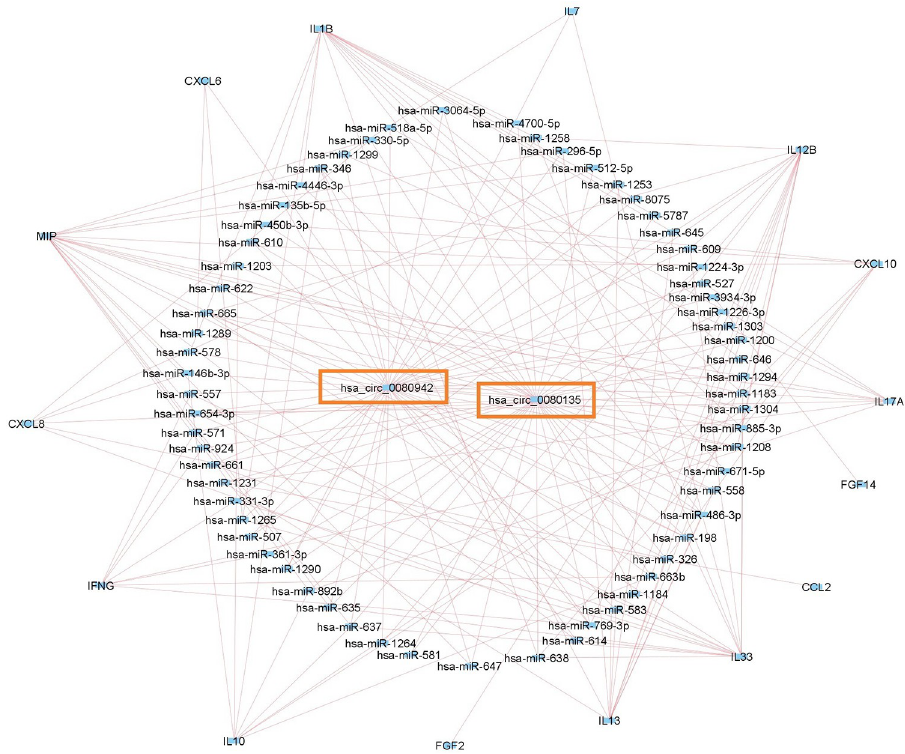
Fig 4. The SARS-CoV-2 induced cytokine storm related circRNA-miRNA-mRNA network visualized using Cytoscape software. The circRNA-miRNA-mRNA network contains 81 nodes and 205 edges.